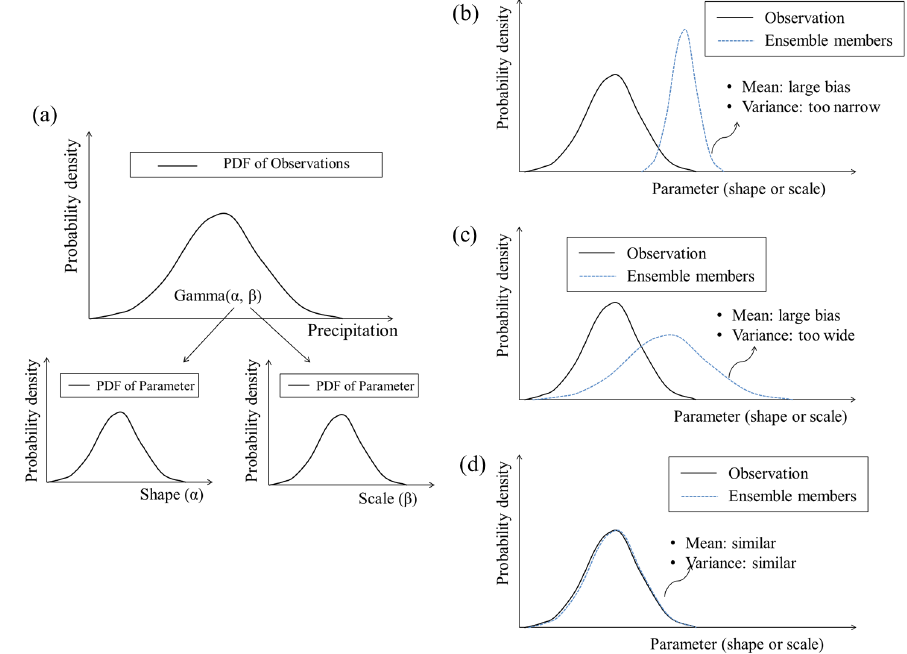
Figure 3. A schematic representation of the evaluation of ensemble members.